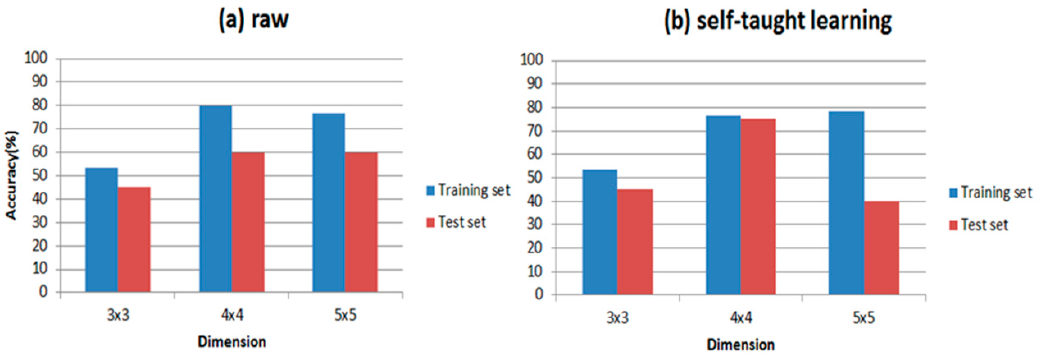
Figure 10. Accuracy with PLSDA. When dimension changes from 3 × 3 to 5 × 5, ( a ) shows the accuracy of unprocessed data set (training set and test set); ( b ) shows the accuracy of data set processed by self taught learning.